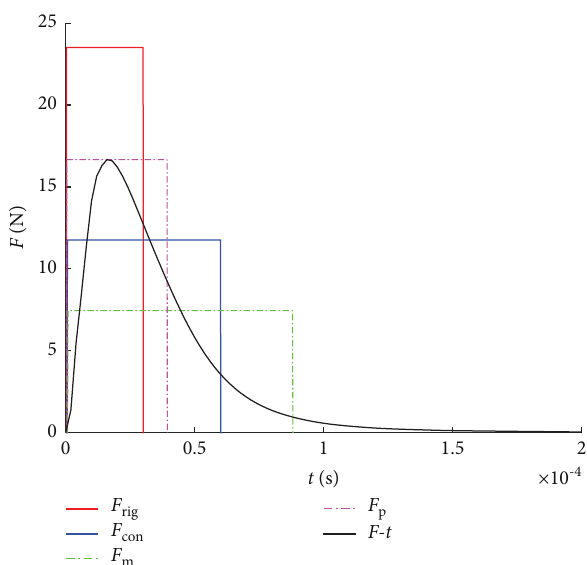
Figure 15: Raindrop impact duration curves with D � 3.0mm, v � 50m/s.